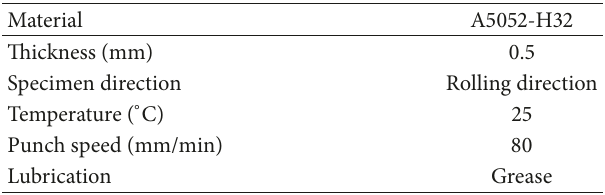
Table 2: FLD test conditions for this